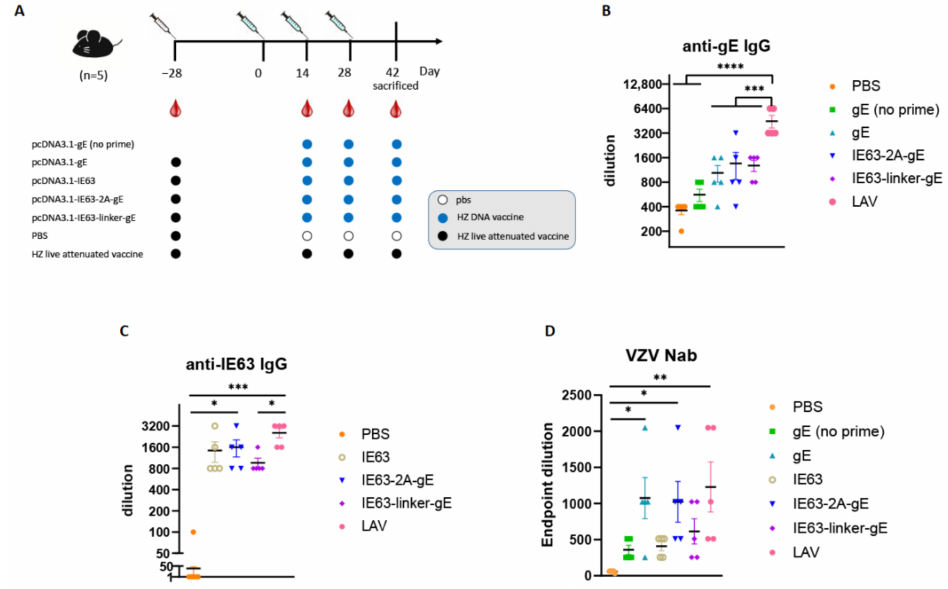
Figure 2. Specific humoral responses of HZ DNA vaccines in C57BL/6 mice. Six- to eight-week-old female C57BL/6 mice were subcutaneously immunized 1/10 human dose HZ live attenuated vaccine at day − 28 (priming immunization), then intramuscularly immunized three times at day 0, day 14 and day 28 with 50 µ g pcDNA3.1-gE, pcDNA3.1-IE63, pcDNA3.1-IE63-2A-gE, or pcDNA3.1-IE63- linker-gE, respectively, by in vivo electroporation ( n = 5 for each group). The pcDNA3.1-gE (no prime) group did not recieve prime immunization with live attenuated vaccine but retained the three pcDNA3.1-gE immunizations. The blood was collected 2 weeks after the last immunization. ( A ) Immunization schedule. Anti-VZV gE antibody titers ( B ) and Anti-VZV IE63 antibody titers ( C ) were quantified by ELISA, respectively, from serum samples collected at day 42. ( D ) Neutralizing antibodies analyzed by FAMA. * p < 0.05; ** p < 0.01; *** p < 0.001; **** p < 0.0001; ns, no significant difference. Data represent mean ± SEM ( n =